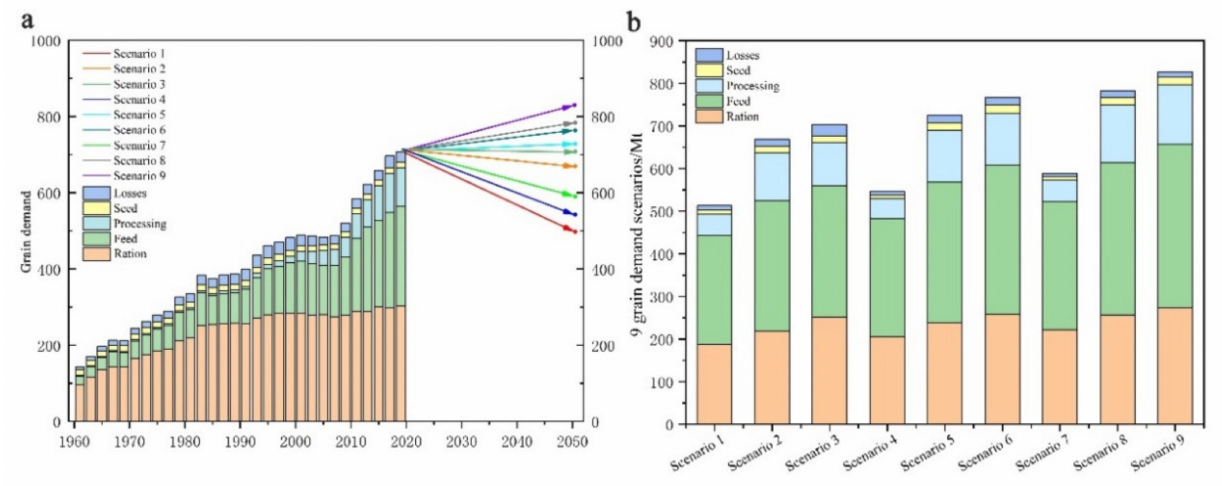
Figure 4. Scenario simulation of 9-grain demand ( a ) during 2020–2050 and comparison of 9 scenarios in 2050 ( b